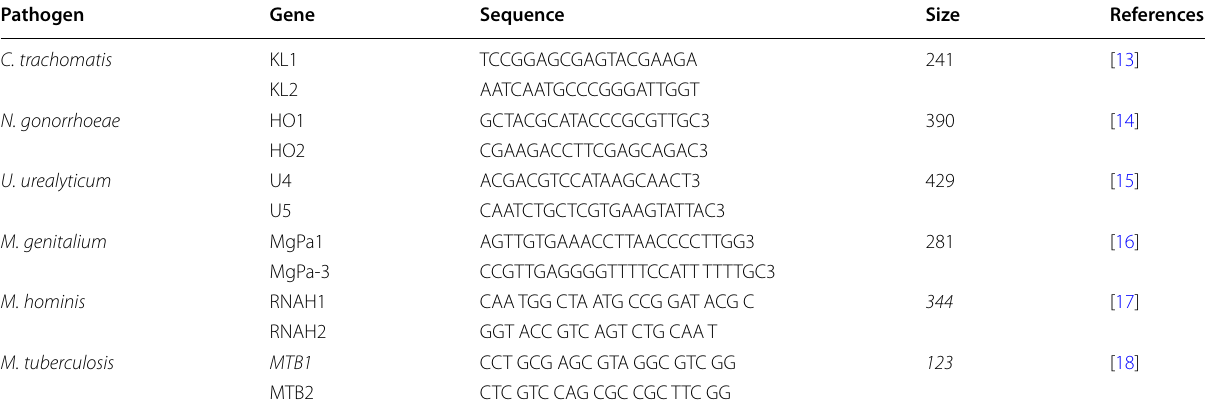
Table 1 Primers used in this study